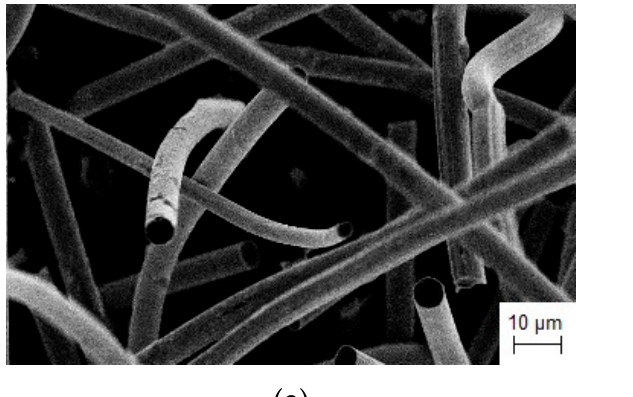
Figure 9. X-ray diffraction patterns of TaC, NbC coatings and Mo 2 C crystals obtained by electro-chemical methods in molten salts on the surface of carbon fibers (solid line). Data points indicate the reference samples.